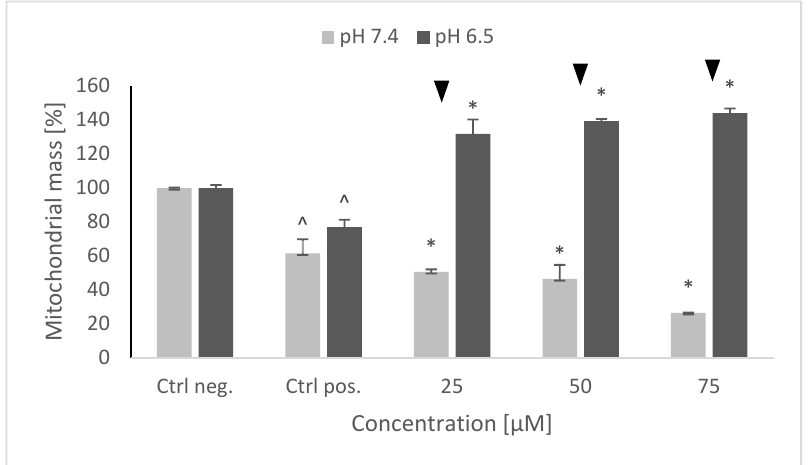
Figure 8. Changes in the mitochondrial mass after pretreatment of SH-SY5Y cells with NRNPs pH and exposure to 6-hydroxydopamine. The whiskers are standard deviation. ^ p ≤ 0.05, Student t -test vs. the negative control (Ctrl neg.; cells not treated with 6-OHDA), ▼ p ≤ 0.05, paired Student t -test, differences between (pH 7.4 vs. pH 6.5), * p ≤ 0.05, Student t -test with respect to the positive control (Ctrl pos.; cells treated with 6-OHDA only, without any pretreatment); n = 3.